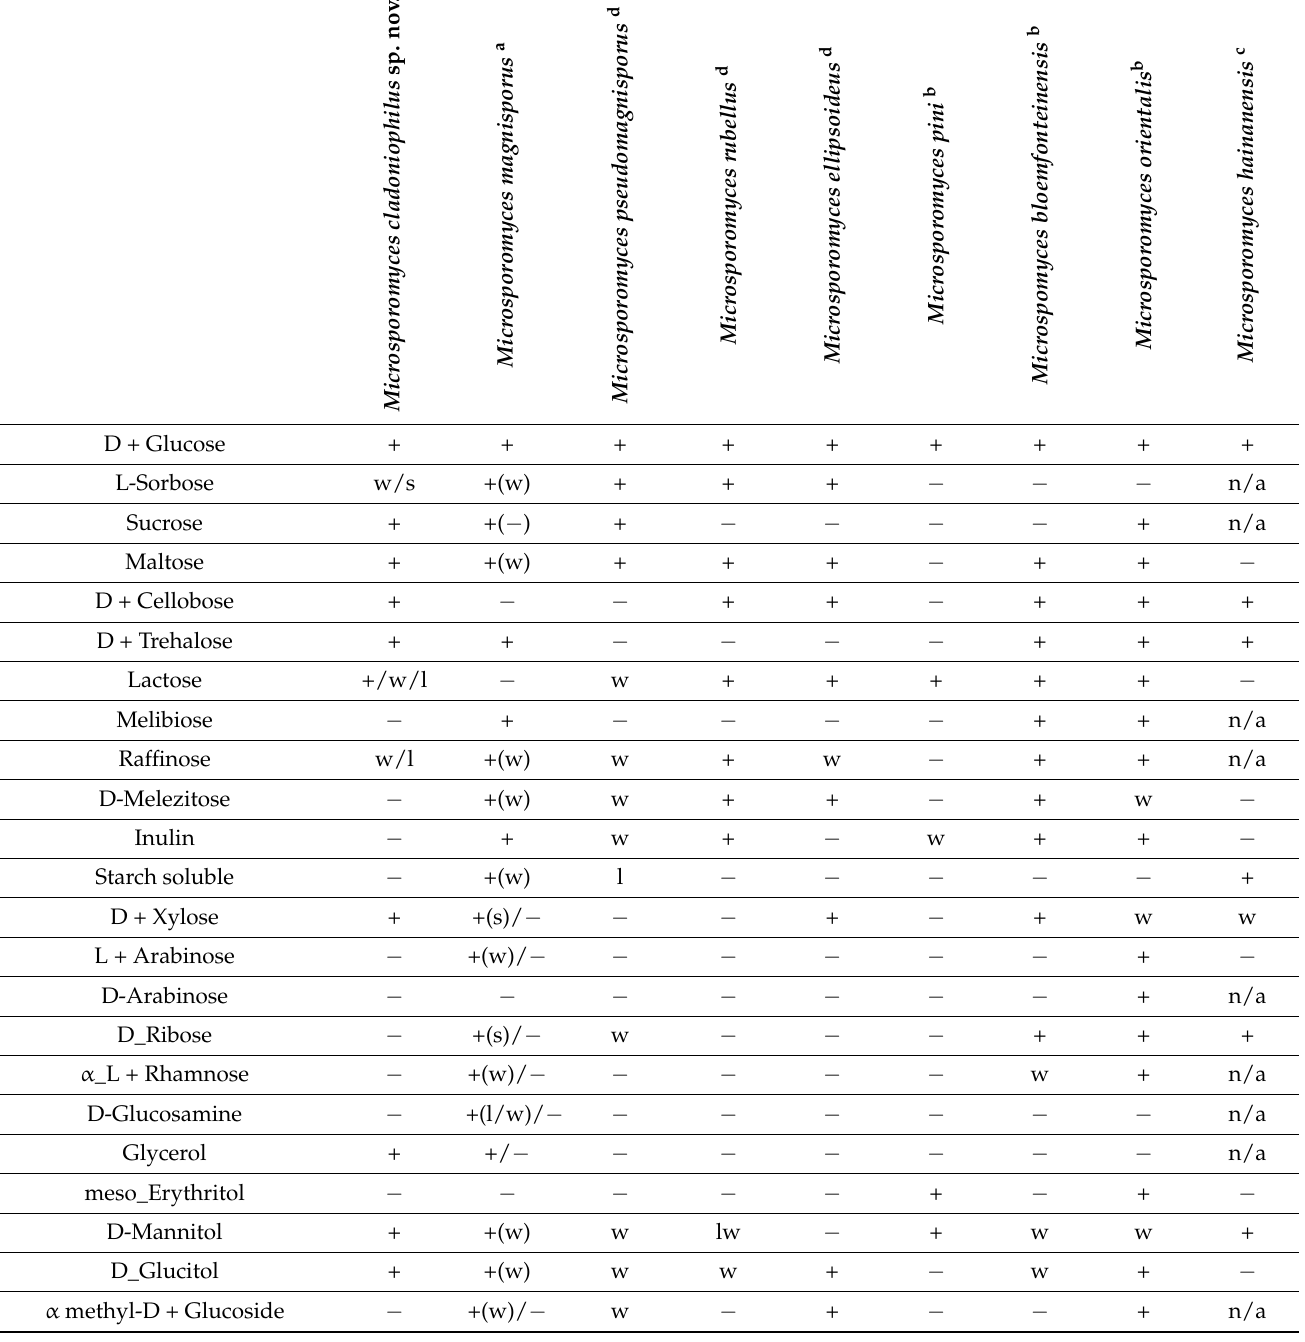
Table 3. Physiological and biochemical characteristics of Microsporomyces cladoniophilus sp. nov. and other species in the Microsporomycetaceae